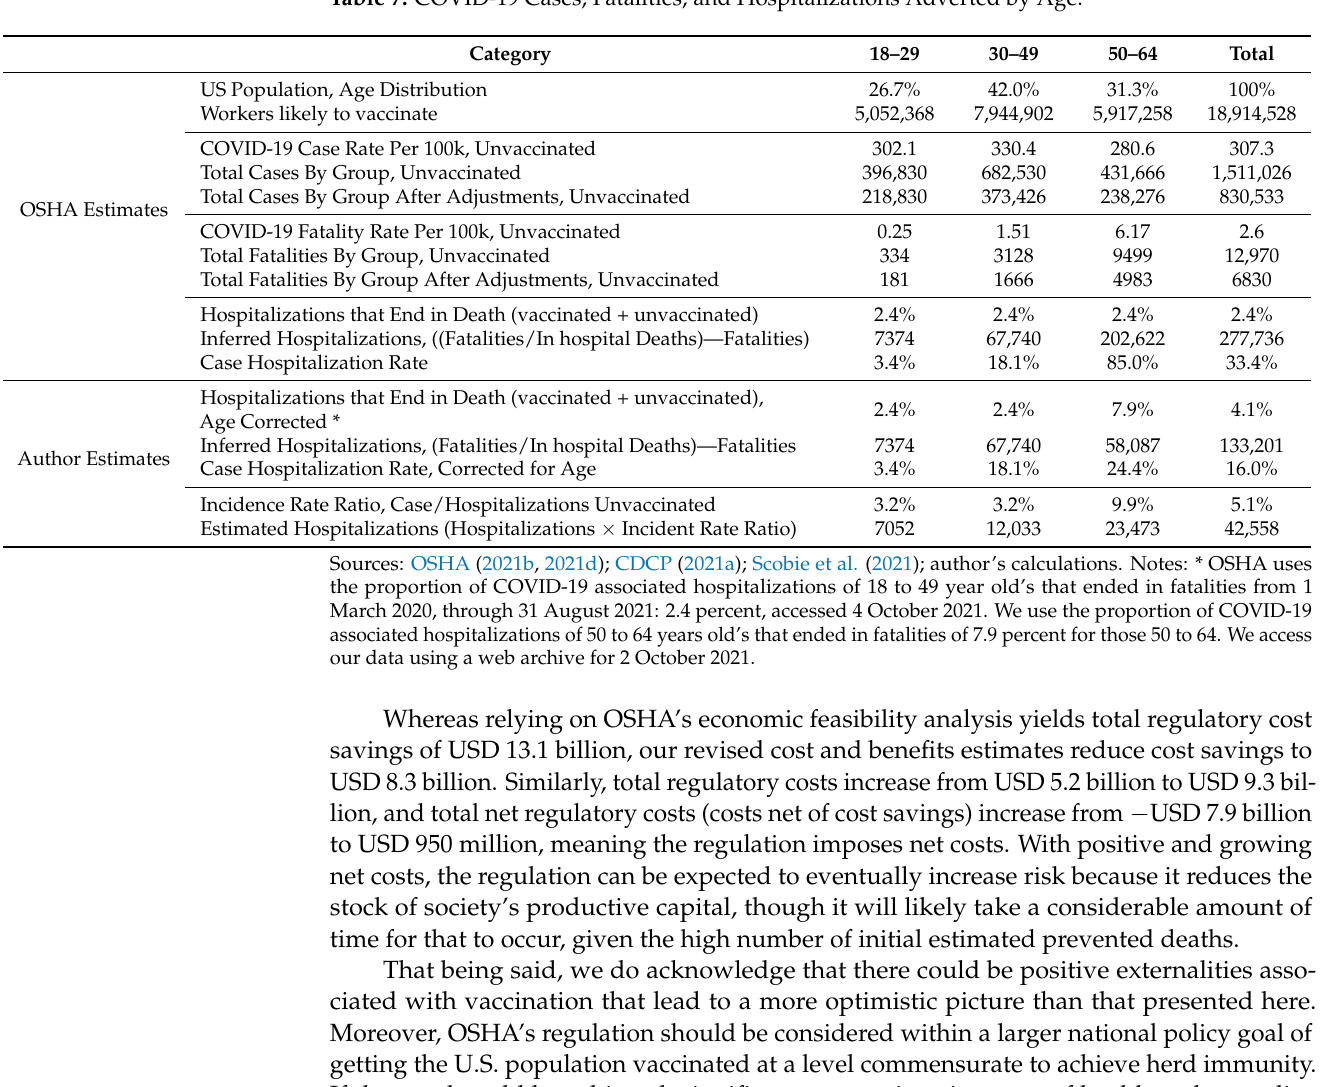
Table 7. COVID-19 Cases, Fatalities, and Hospitalizations Adverted by